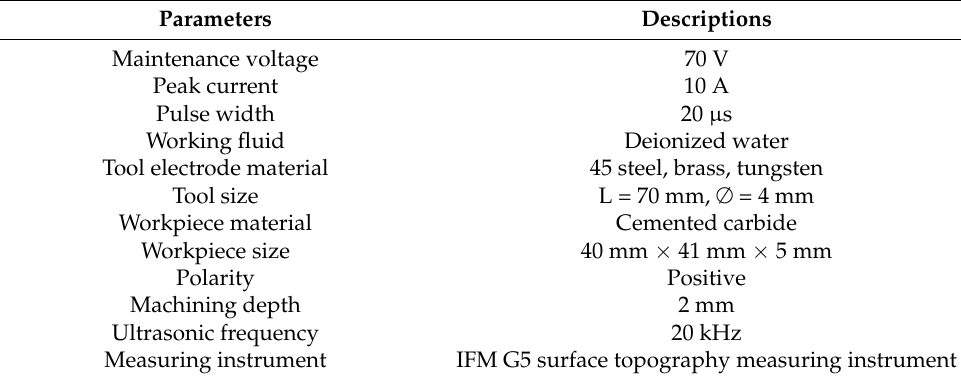
Table 1. Experimental parameters of EDM